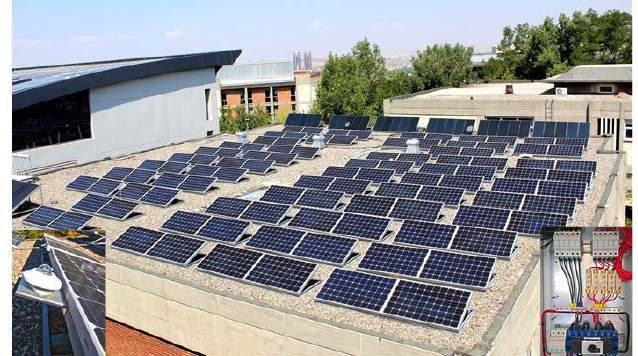
Figure 2. Roof-mounted 23.7 kW at 1000 W/m 2 and 25 °C multi-string PV system containing 95 CSUN250- 72M modules (five parallel connected strings of 19 series modules; with adjustable tilt angles of 15°, 30°, 45° and 60°); coordinates 39.890917, 32.782278; five modules in the photograph are idle; terminal box of the system inside the laboratory is shown at the right bottom corner of photograph while the pyranometer is at left bottom corner.